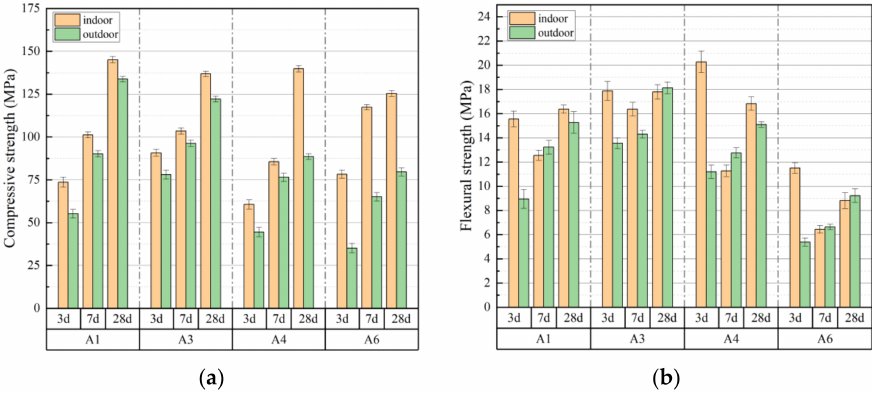
Figure 8. Comparison of indoor and outdoor mechanical properties of UHPC based on composite cementitious material: ( a ) Compressive strength, ( b ) Flexural strength.